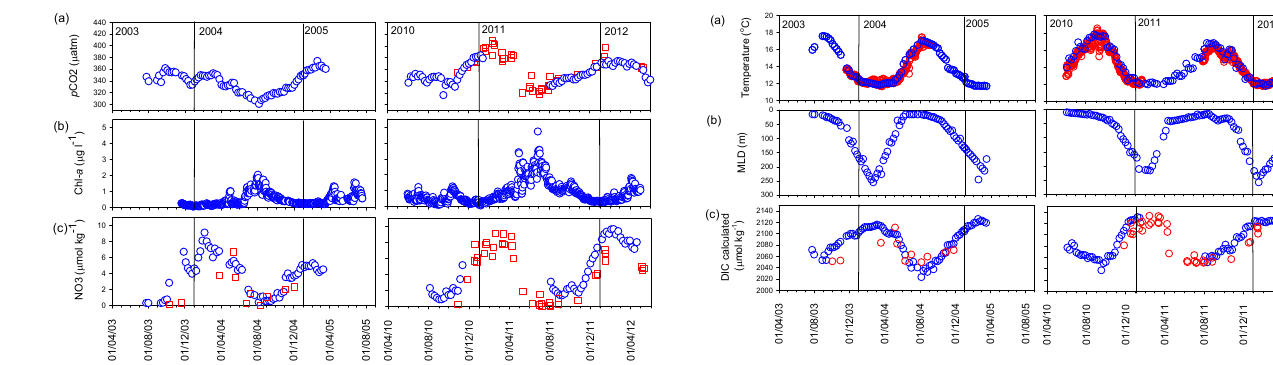
Figure 2. In situ 30m PAP-SO data (blue circles) from 2003 to 2005 and 2010 to 2012 and 5m SOO data (red squares) with vertical lines to represent the start of each year showing: (a) p (CO 2 ); (b) chloro- phyll a concentration; (c) weekly-averaged nitrate concentration.